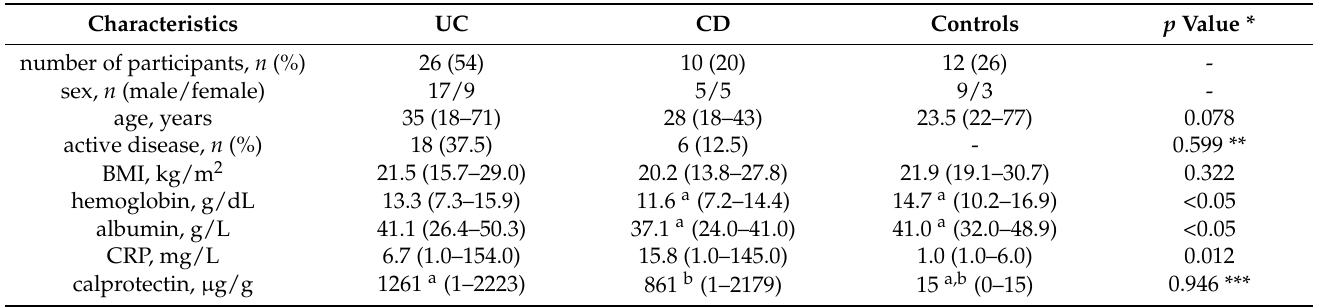
Table 1. Characteristics of patients with ulcerative colitis (UC), Crohn’s disease (CD), and controls.